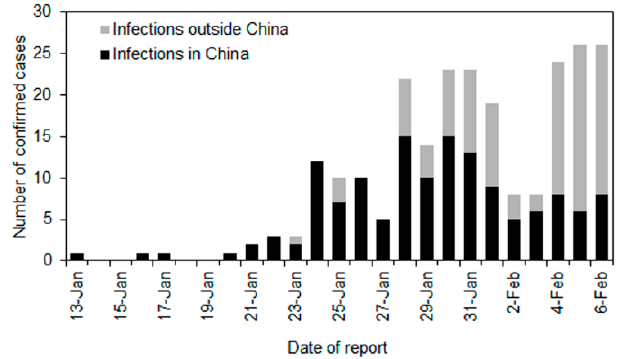
Figure 1. Number of confirmed cases outside China by date of report. The bars measure the number of cases reported each day between 13 January and 6 February 2020. The black bars represent infections that are likely to have occurred in China while the grey bars indicate infections that are likely to have occurred outside China.